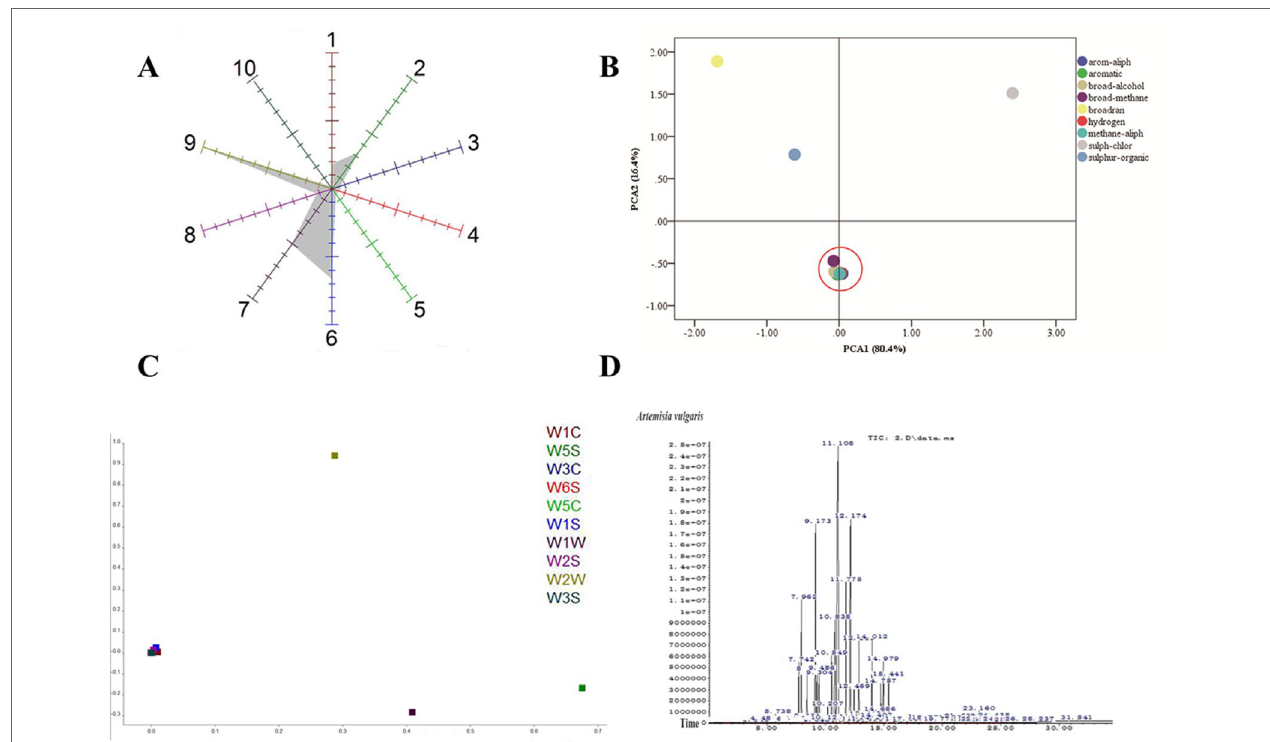
FIGURE 2 | Component analysis of Artemisia vulgaris L. essential oils (AV-EOs). (A) Polar plot display of sensor values of EOs from AV at 57 s given by the cursor in the measurement window; (B) principal component analysis (PCA); (C) loading (Lo) analysis; W1C (aromatic), W5S (broadrange), W3C (aromatic), W6S (hydrogen), W5C (arom-aliph), W1S (broad-methane), W1W (sulphur-organic), W2S (broad-alcohol), W2W (sulph-chlor), W3S (methane-aliph); (D) the headspace solid-phase microextraction coupled with gas chromatography (HS-SPME-GC-MS) diagram of